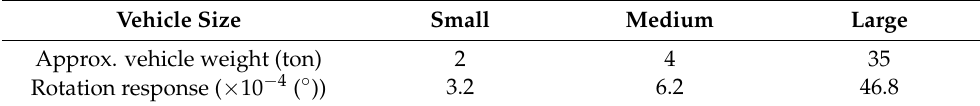
Table 3. Rotation responses generated by different types of